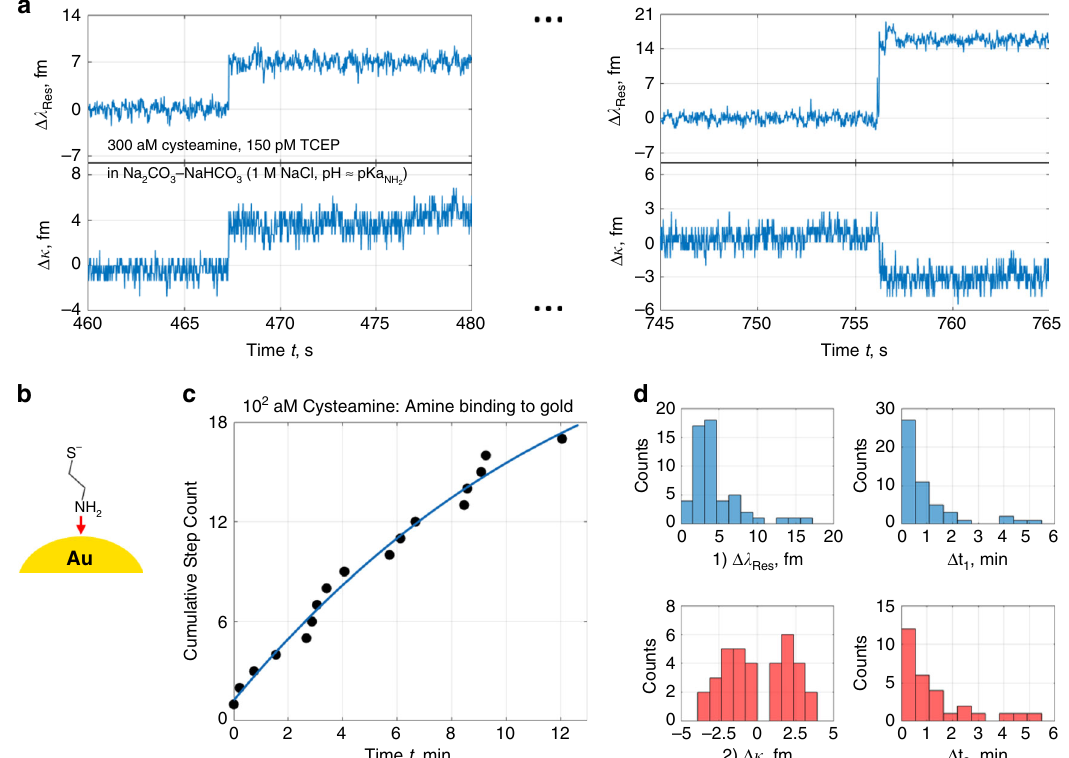
Fig. 2 Single cysteamine binding to gold NRs via amine at subfemtomolar concentration. a Discrete signals in the LSP-WGM resonance trace from covalent bonding of the NH 2 ligands to Au in a basic buffer. b Conceptual diagram of the cysteamine surface reaction. Cysteamine, with its thiol and amine groups, forms an amine-gold bond as indicated by the red arrow. c Exponential decay in cumulative binding step count as the system approaches saturation. In this regime, it is necessary to periodically inject more analyte in solution as scarce analytes are lost to external immobilisation (i.e. from undetected NRs that are not excited by the WGM). d Histograms depicting the resonance shift Δ λ and linewidth shift Δ κ for binding events, as well as Res their related event time separations Δ t 1 and Δ t 2 . The Δ κ distribution shows both positive and negative shifts, while Δ t 1 and Δ t 2 distributions are